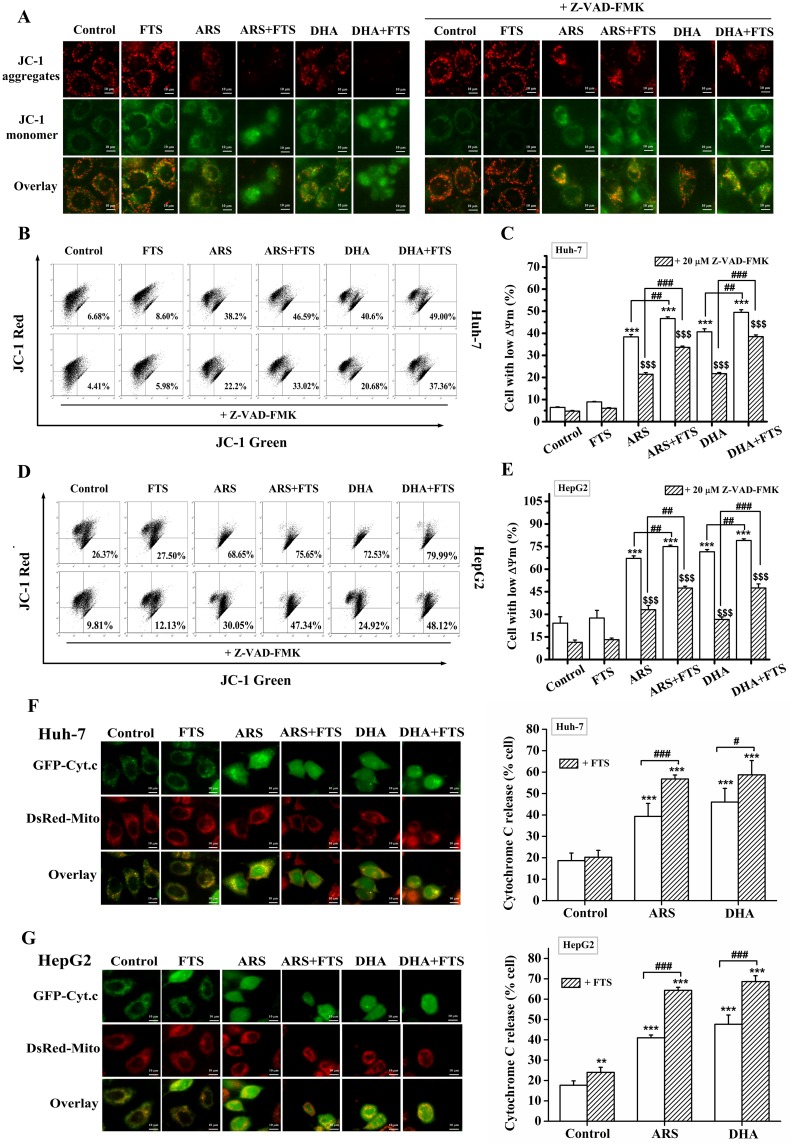
FTS promotes DHA/ARS-induced mitochondrial membrane depolarization and cytochrome c release.(A) Fluorescence images of HepG2 cells stained with JC-1 (5 μg/mL) under different treatments. (B and D) Typical FCM results on the loss of ΔΨm in Huh-7 cells (B) and HepG2 (D) cells. Cells were pretreated with Z-VAD-FMK (pan-caspase inhibitor, 20 μM) for 30 min before FTS/DHA/ARS treatment or the combination treatment of FTS and DHA/ARS for 48 h and then stained with JC-1 before being analyzed by FCM. (C and E) Statistical results of three independent FCM analyses on ΔΨm loss in Huh-7 (C) and HepG2 (E) cells. Scale Bar: 10 μm. ***P < 0.001, compared with control from the group of without Z-VAD-FMK; $ $ $P < 0.001, compared with control from the group of with Z-VAD-FMK; ##P < 0.01 and ###P < 0.001. (F and G) Fluorescence images (left) of cells expressing GFP-Cyt.c under different treatments and statistical results (right) of cells showing cytochrome c release from 300 cells in three independent experiments in Huh-7 (F) and HepG2 (G) cells. Cells transfected with GFP-Cyt.c plasmid were under different treatments for 12 h, and then stained with Mito-tracker red to label mitochondria before fluorescence microscopic imaging. Scale bar: 10 μm. **P < 0.01 and ***P < 0.001, compared with control; #P < 0.05 and ###P < 0.001.